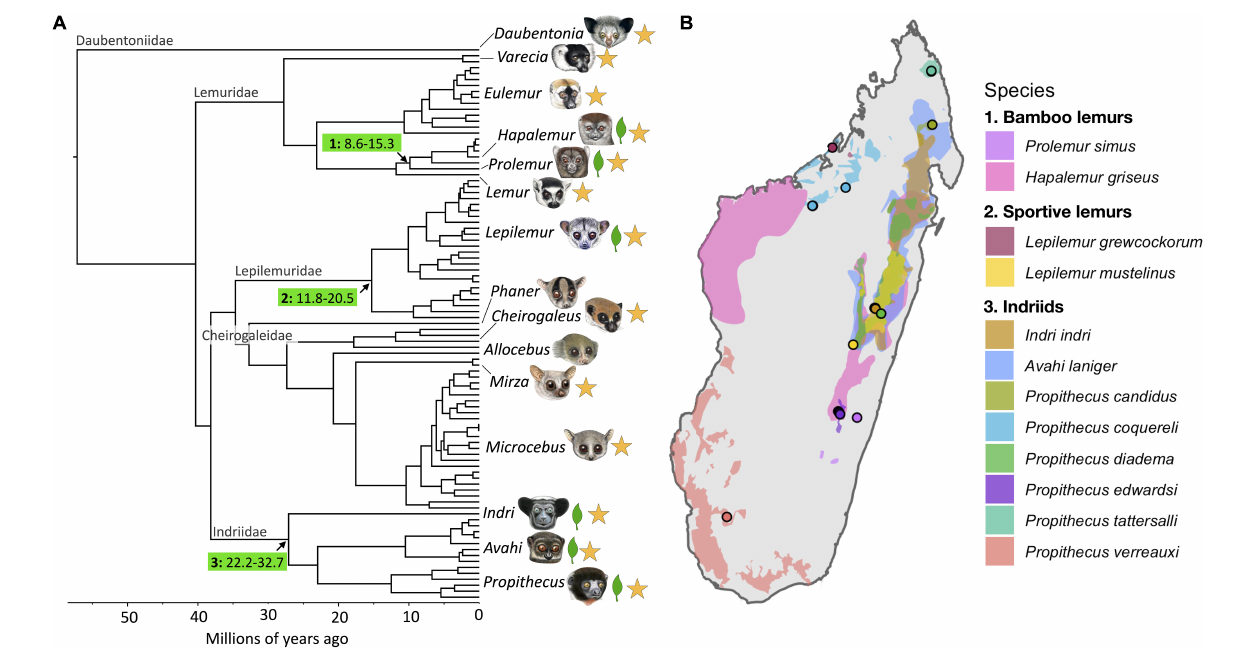
FIGURE 1 | Species included in this study. (A) Lemur phylogeny adapted from dos Reis et al. (2018). Illustrations copyright 2020 Stephen D. Nash / IUCN SSC Primate Specialist Group. Used with permission. Arrows denote branches along which folivory emerged, with numbers in the green boxes reflecting the three folivorous lemur groups: 1: bamboo lemurs, 2: sportive lemurs and 3: indriids and number ranges indicating 95% confidence intervals for the time (in millions of years ago) of the basal split in that group from dos Reis et al. (2018). Leaf icons at tips denote folivorous genera and stars denote genera represented in this study. (B) Range maps of folivorous species included in this study from IUCN Red List of Threatened Species. Points indicate sampling localities for wild individuals